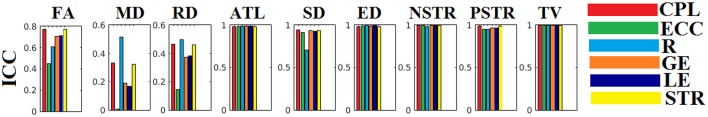
ICC values for basic network metrics on the network level for each of the nine NWS. CPL, Characteristic Path Length; ECC, Eccentricity; R, Radius; GE, Global Efficiency; LE, Local Efficiency; STR, mean strength.